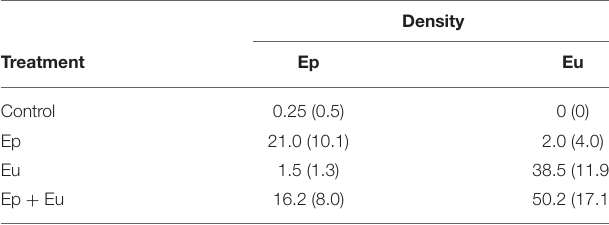
TABLE 1 | Mean (and standard deviation) densities of Collembola (number of individuals) in each treatment after 2 months.